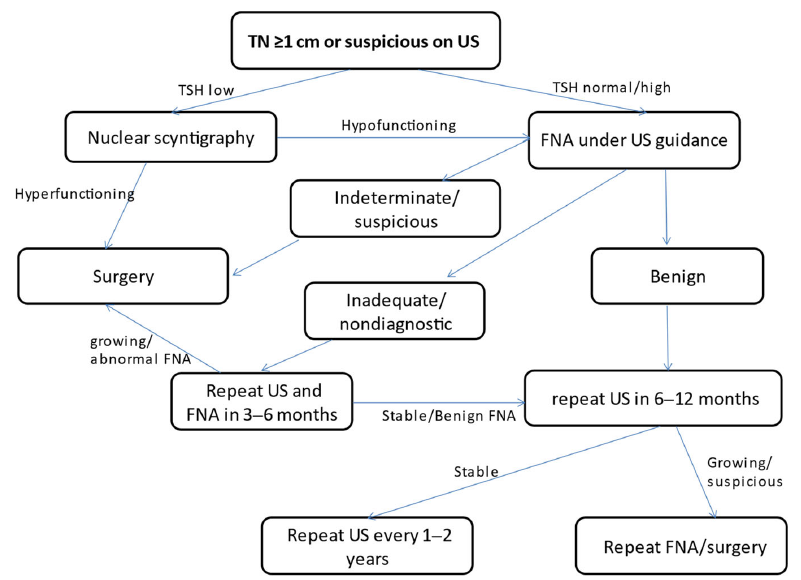
Figure 3. Pathogenesis, diagnosis, and management of thyroid nodules in children (adapted from Management Guidelines for Children with Thyroid Nodules and Differentiated Thyroid Cancer [74]).